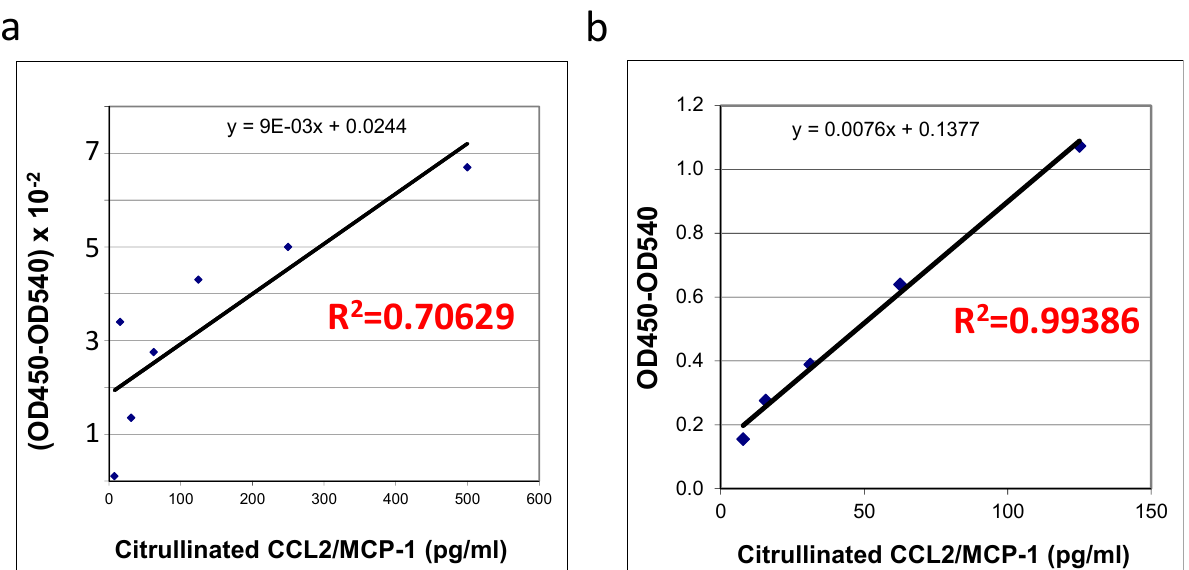
Figure 3. Detection of citrullinated recombinant human MCP-1/CCL2. Standard curves of citrulli- nated recombinant human MCP-1/CCL2 were set up using enzyme-linked immunosorbent assay in duplicate ( a ) standard curve of citrullinated E. coli produced recombinant human MCP-1/CCL2 chemokine (R&D Systems), ( b ) standard curve for citrullinated MCP-1/CCL2 chemokine produced by and purified from human HEK 293T cells. Absorbance at 450 nm is shown. Coefficients of deter- mination R 2 are indicated in red on the relevant plots. Results shown are a representative of three or more repetitive experiments.